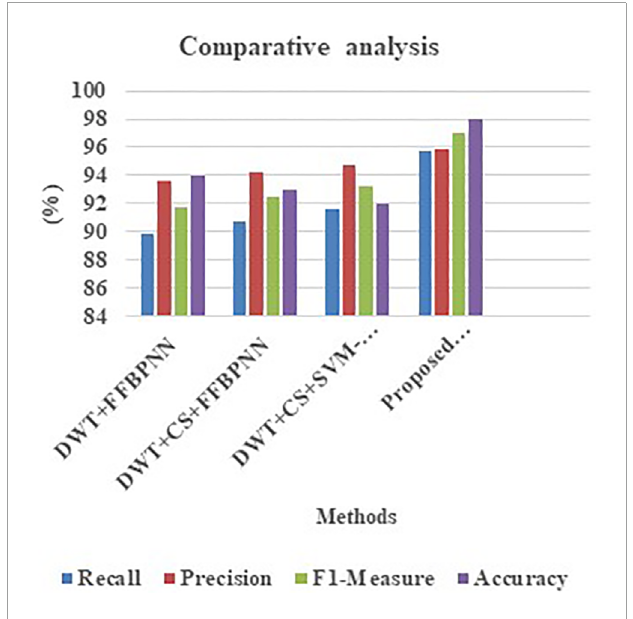
FIGURE 5 Comparative analysis of recall, precision, F1-measure, and accuracy.